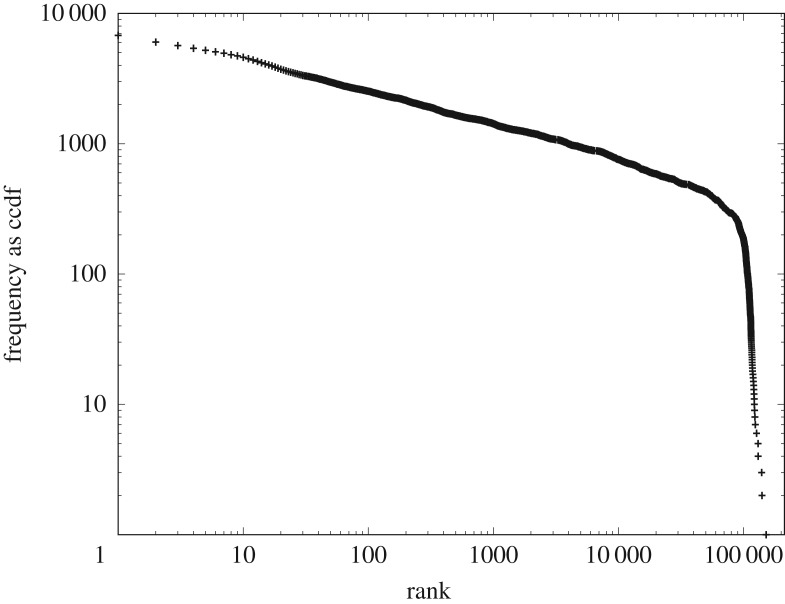
The heterogeneous distribution of protein lengths in figure 5 grouped as a homogeneous distribution and plotted as frequency versus rank.